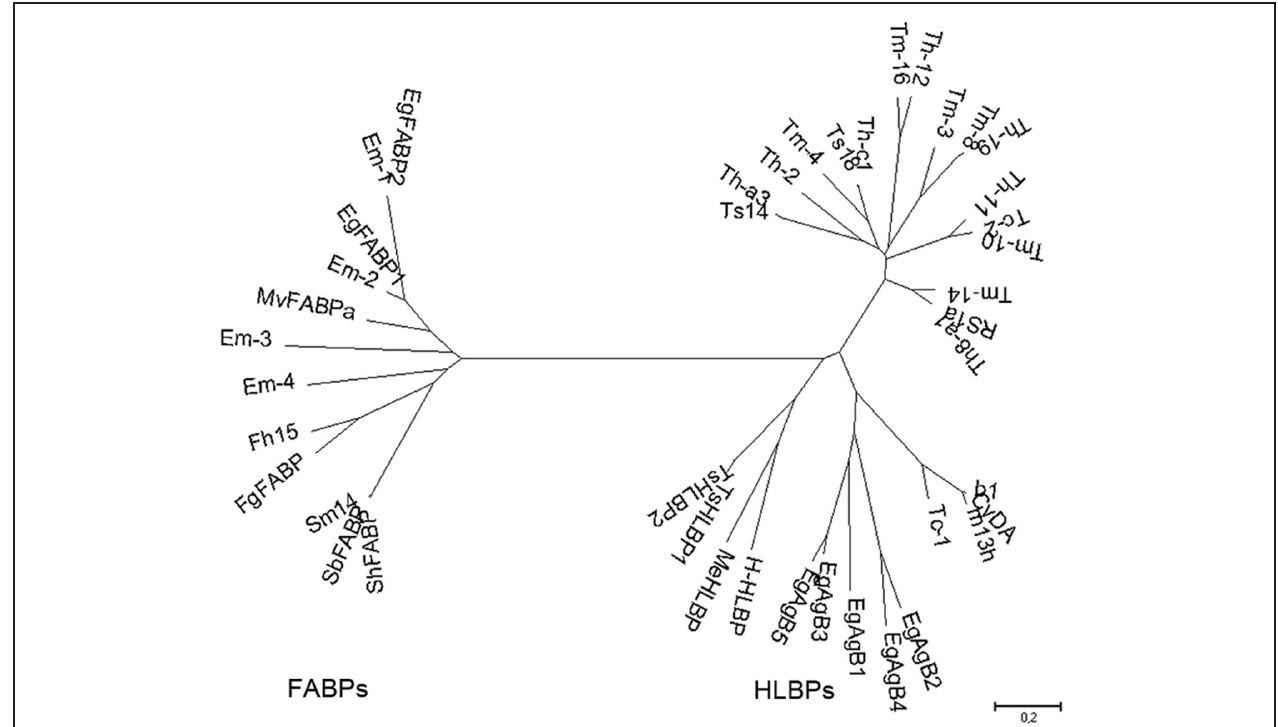
FIGURE 1 | Phylogenetic relationships among platyhelminth FABPs and HLBPs. Consensus tree derived from neighbor joining analysis of the following sequences: EgFABP1 and EgFABP2 from Echinococcus granulosus ; Em-1 (EmW_000549800), Em-2 (EmW_000550000), Em-3 (EmW_000551000), and Em-4 (EmW_000417200) from E. multilocularis ( http://www . genedb . org/ ); Fh15 from Fasciola hepatica ; FgFABP from